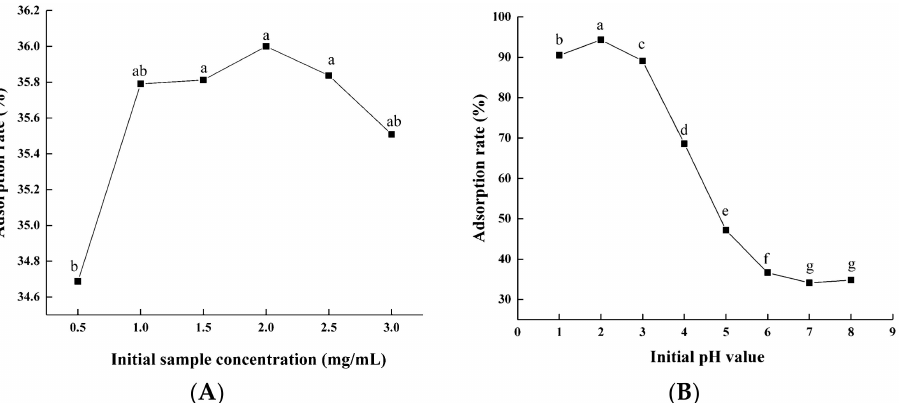
Figure 1. Effects of initial sample solution concentration ( A ) and pH value ( B ) on the adsorption rate of macroporous resin. Experiments were performed in triplicate, and data are expressed as the mean ± SE. Different lowercase superscript letters denote statistically significant differences ( p <